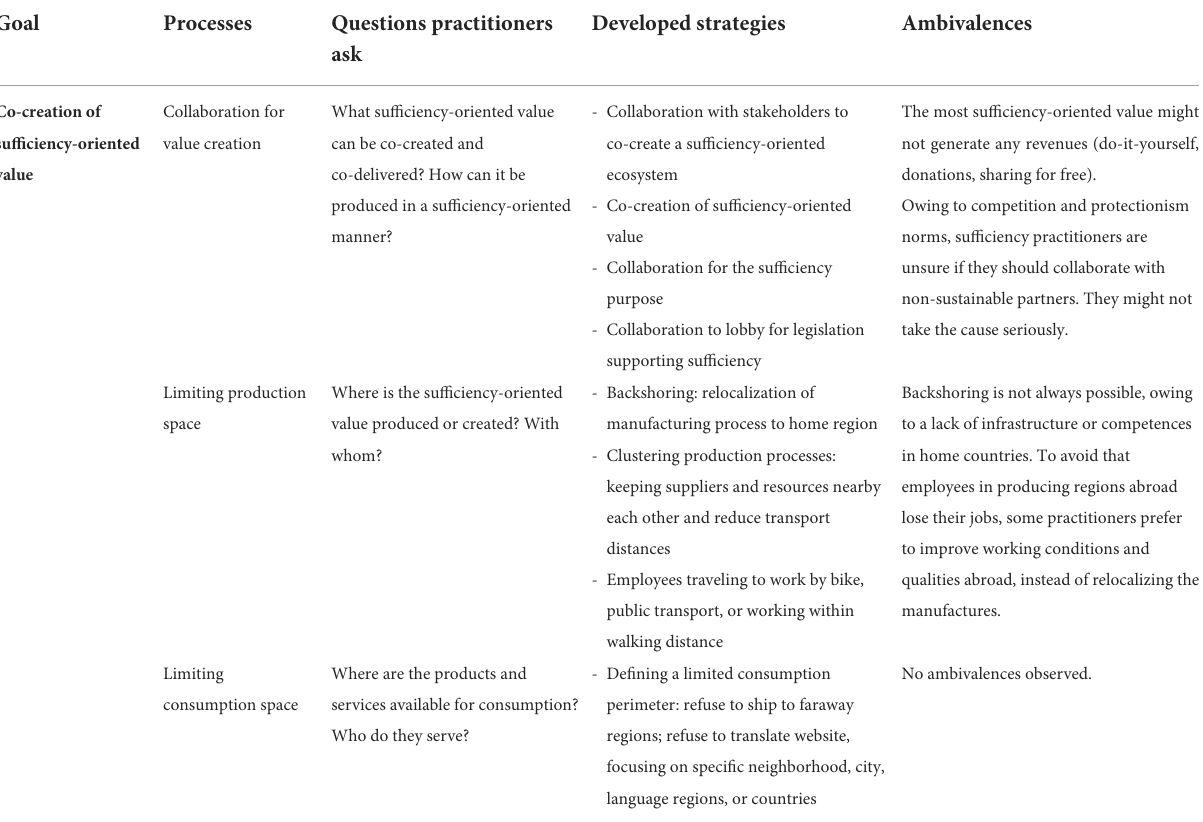
TABLE 6 “Rethinking relation to others”: Relevant questions, strategies, and emerging